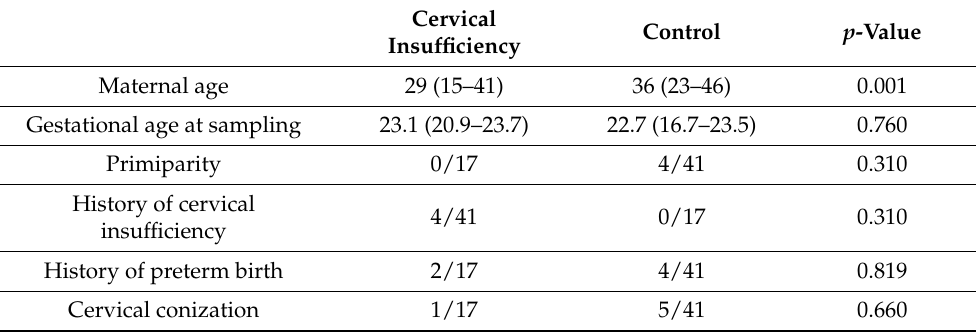
Table 2. Baseline patient characteristics.